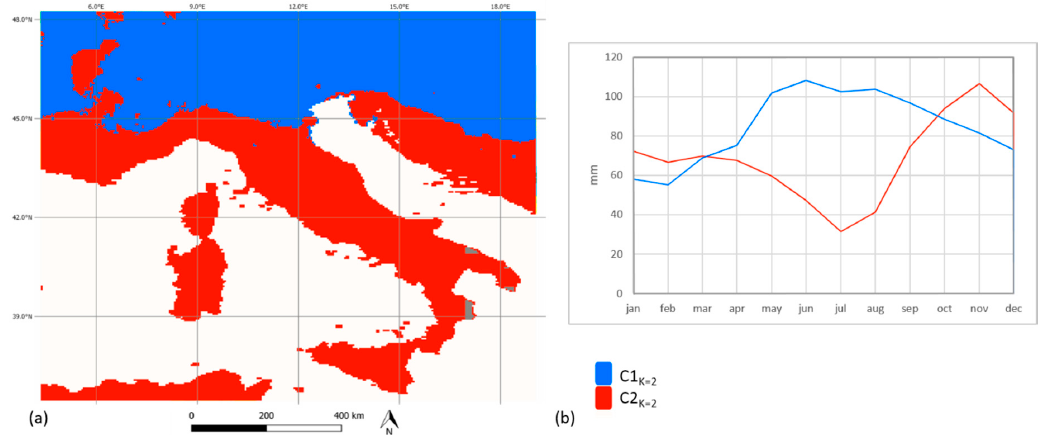
Figure 5. Clusters ( a ) and centroids ( b ) obtained for the optimal clustering with K = 2. Note that real values are reported in ( b ).